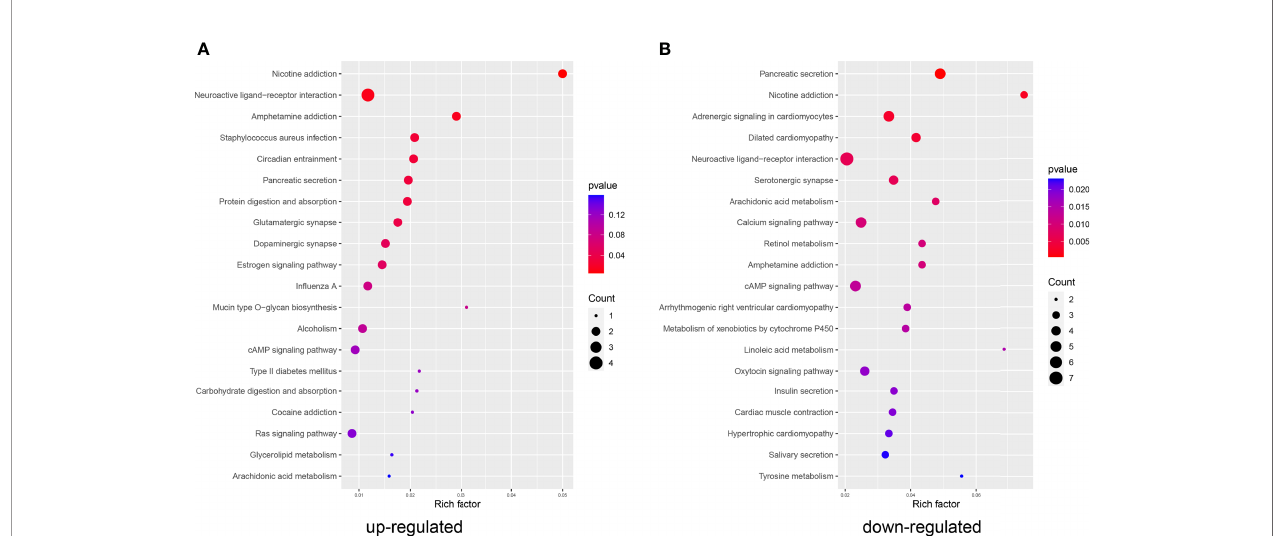
FIGURE 2 | KEGG analysis. Functions and pathways enriched in the (A) upregulated and (B) downregulated genes in the LS group compared to the ES group.